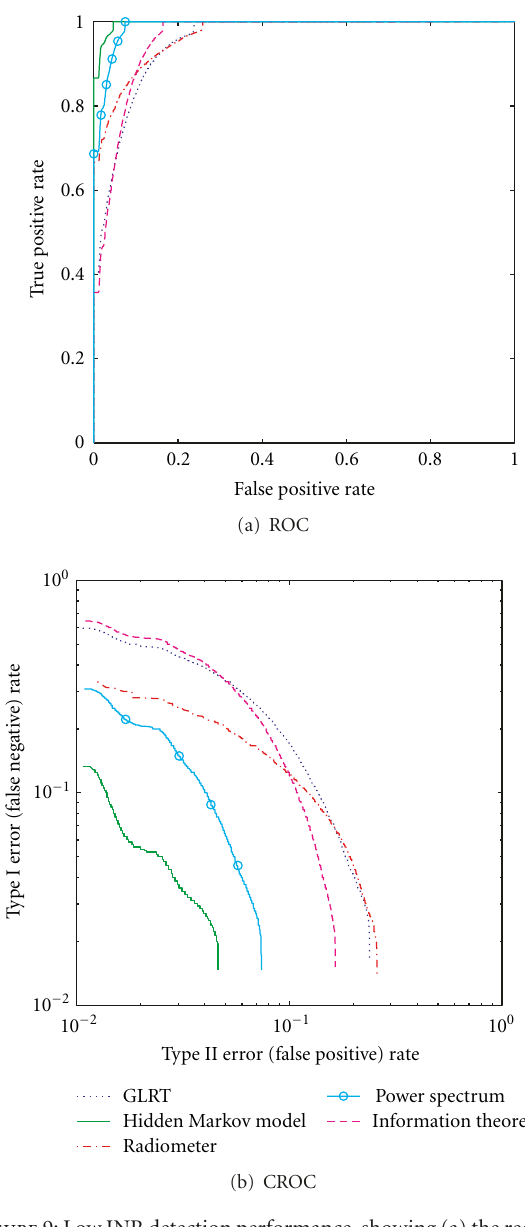
Figure 9: Low INR detection performance, showing (a) the receiver operating characteristic and (b) the complementary receiver oper- ating characteristic, for an N = 100 length sample vector produced by aggregating results of 100 000 trials. Four interferers of random bandwidth, power, and demodulated carrier frequency were used in each simulation, with INRs uniformly distributed over the range − 10dB to +10dB. The legend in (a) applies to both subfigures. Note that the best performance region of the ROC (a) is the top left and that the best performance region of the CROC (b) is the bottom